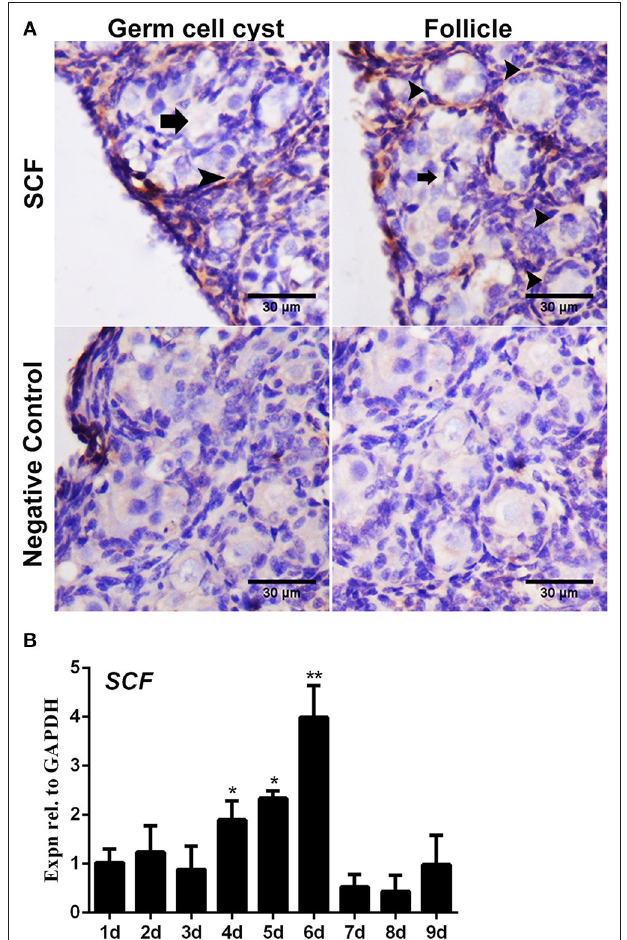
FIGURE 3 | Expression of SCF mRNA in the chicken ovaries. SCF mRNA showed staining in the cell cytoplasm by in situ hybridization. (A) SCF mRNA was detected in the cytoplasm in 6-day-old chicken ovarian cells. Arrows and arrowheads represent the cysts and follicles, respectively. (B) SCF mRNA expression was measured by qRT-PCR in the chicken ovaries from Day 1 to 9. GAPDH was used as the normalization control. T -tests were used to determine statistically significant differences. The values are the mean ± SEM of six experiments. Asterisks indicate significant differences (* P < 0.05, ** P < 0.01).